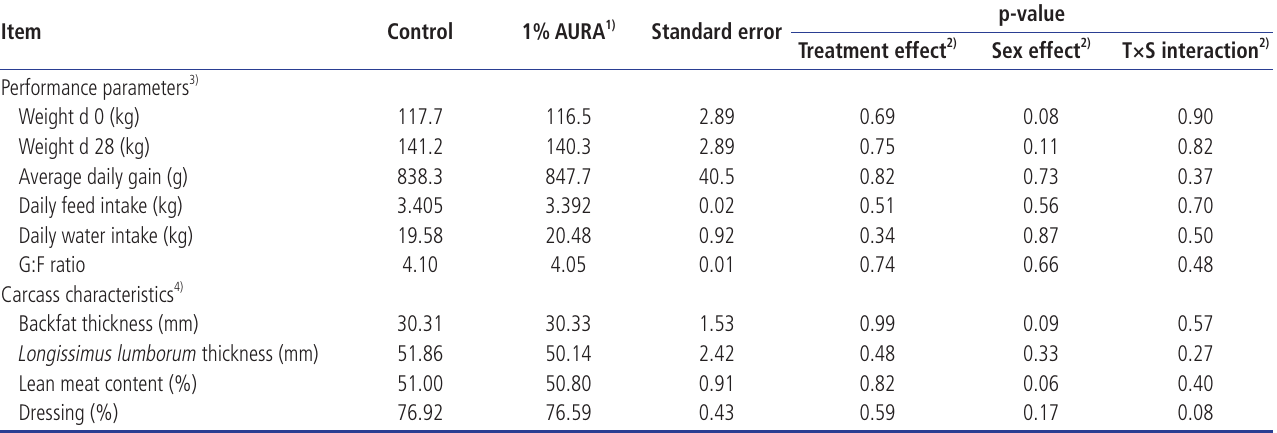
Table 3. Effect of supplementation with a docosahexaenoic-rich microalgae (AURA) at 1% of diet on performance parameters and carcass characteristics of finishing pigs Item